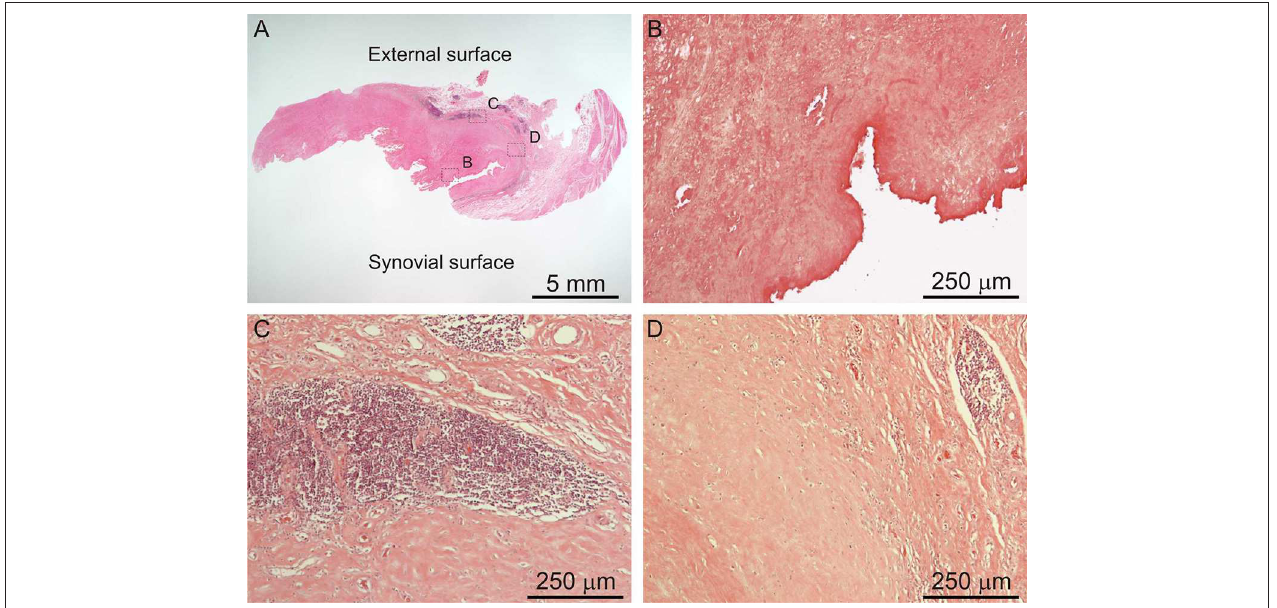
FIGURE 5 | Histological images of ALTR. Low magnification of biopsied lesions (A) , characterized by synovial ulceration and sub superficial necrosis (B) , mononuclear cell infiltration (C) , and macrophages (D)